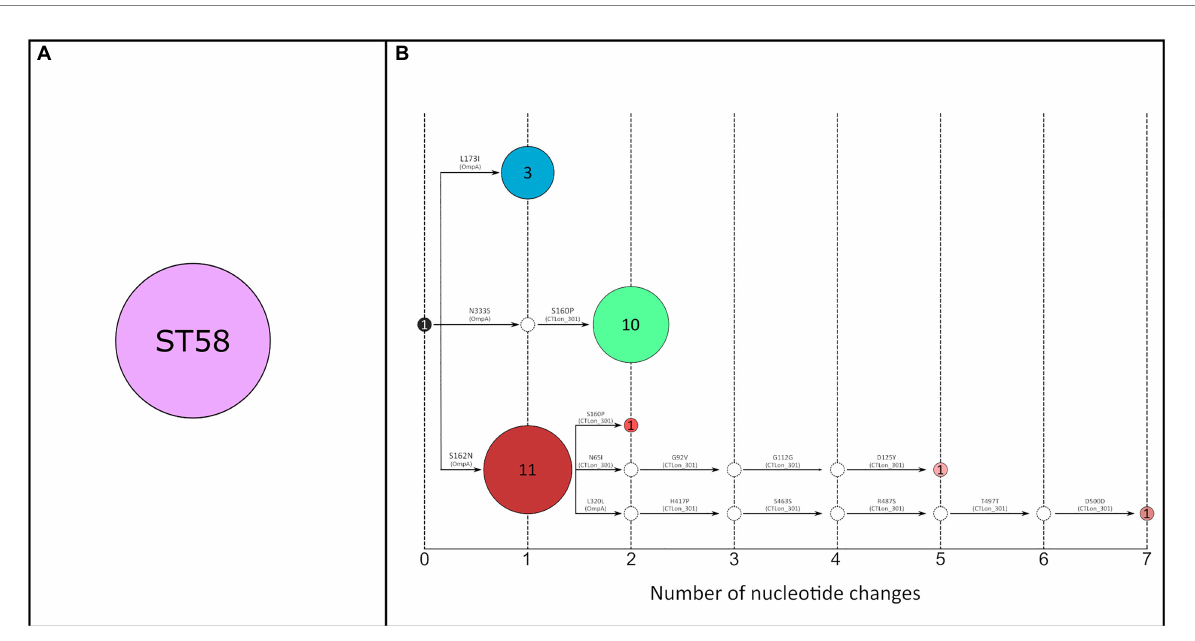
FIGURE 2 (A) Transmission network constructed using the concatenated genes of the MLST scheme proposed by Klint et al. (2007) (2,682 bp) ( n = 28). All samples belong to ST58 (purple circle). (B) Transmission network constructed using the concatenated genes of the scheme proposed in this study (4,042 bp) ( n = 28). A total of seven variants were identified. The number inside the circles corresponds to the number of samples included in each node. Each color represents a different variant. White circles correspond to hypothetical ancestors; the black circle corresponds to the L2b variant reported in Netherlands; red-tone circles correspond to L2b- ompA L2 variants; blue-tone circles correspond to L2bV1 variants and green-tone circles correspond to L2bV7 variants. Amino acid changes are indicated in each arm referred to as L2b/UCH-1 (AM884177), and the gene where each mutation is located is shown in